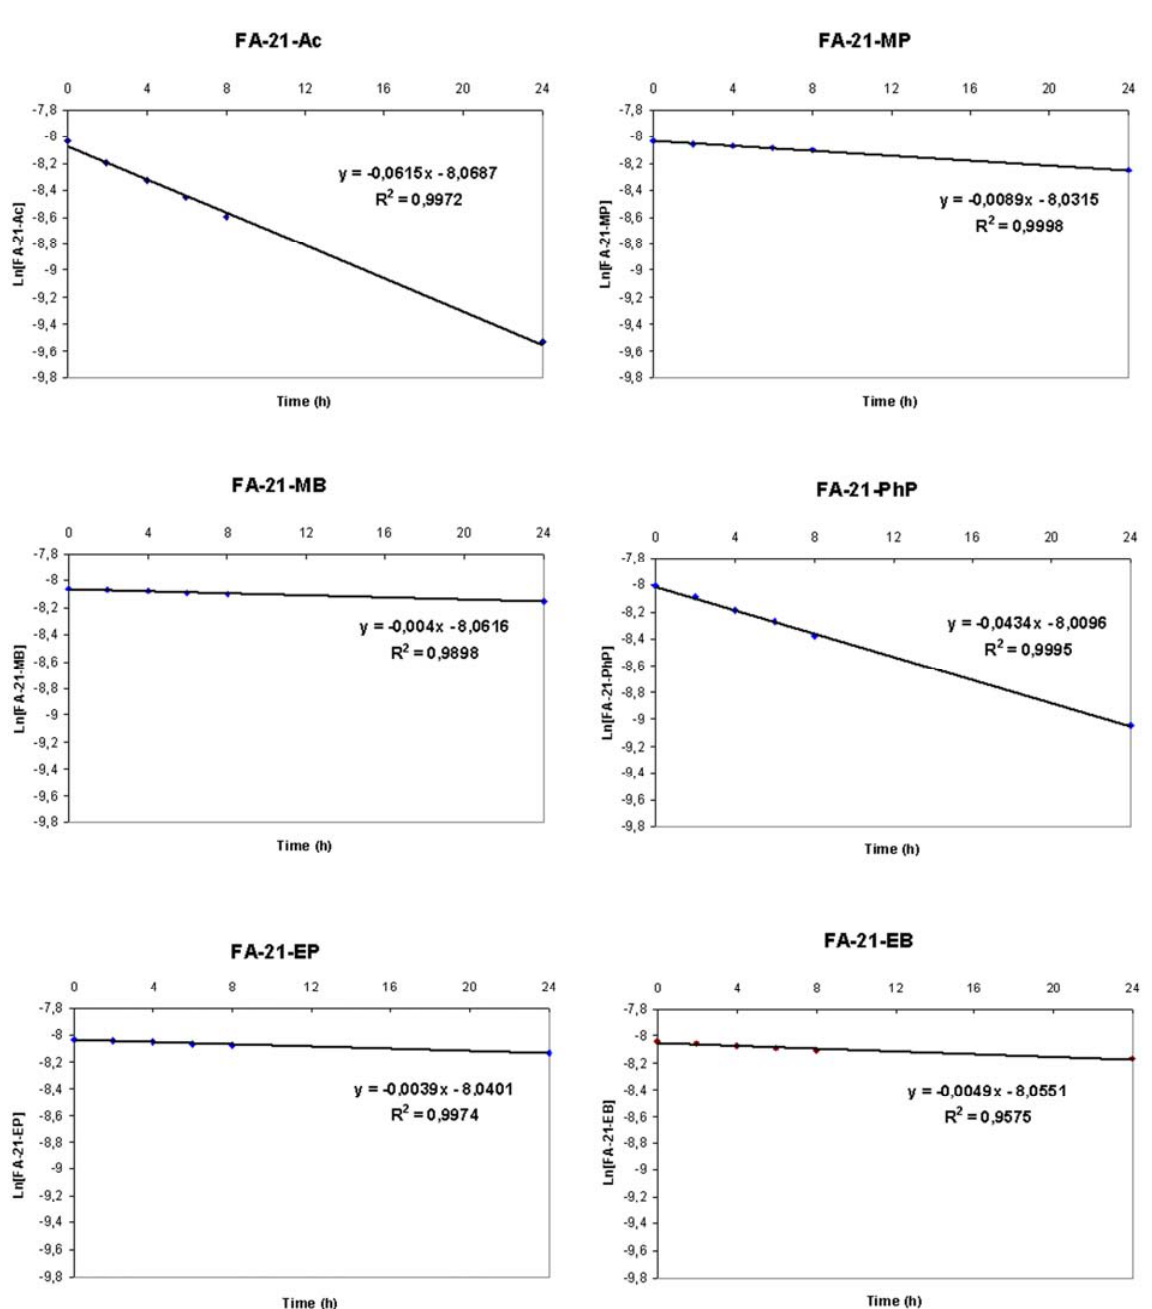
Figure 1. Solvolysis of six fluocinolone acetonide